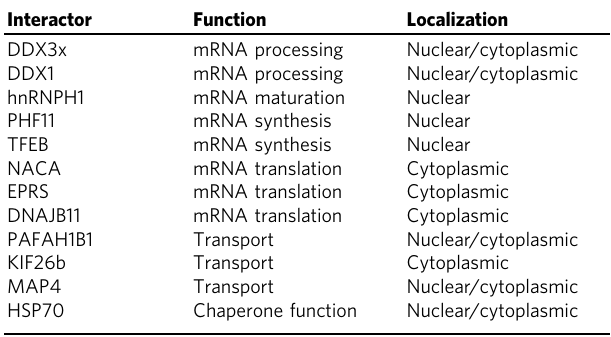
Table 1 Summary of BEX1-interacting proteins assembled from 3 different screens that fi t into a classi fi cation of RNA interacting, transport and